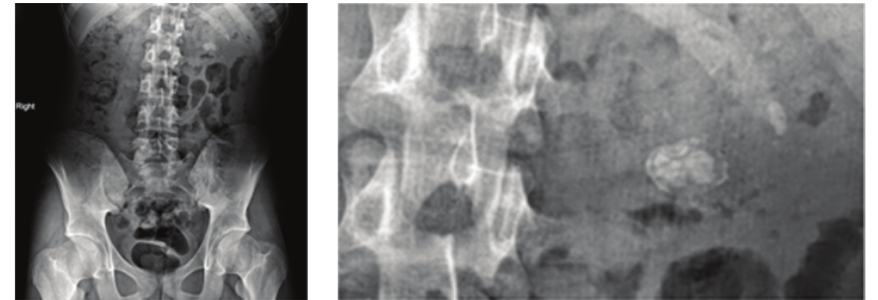
Figure 1: Preoperative KUB radiography of patient.